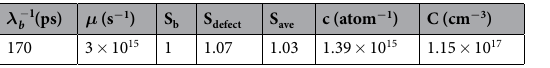
Table 3. Zinc vacancy concentration in the quenched